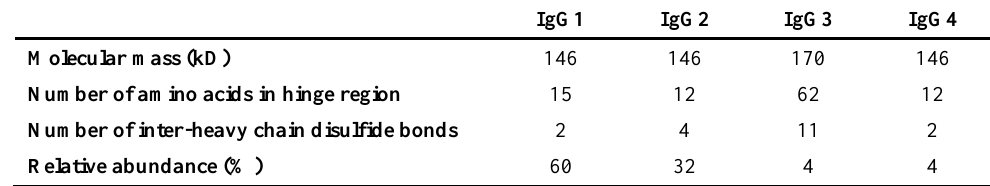
Table 1 General property of human IgG subclasses (modified from Vidarsson et al. ,